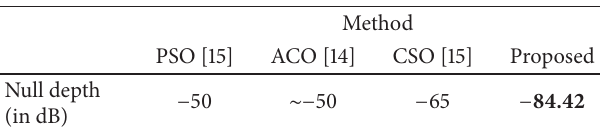
Table 5: Comparative analysis of null depth (in dB) obtained by various optimization algorithms for Example 2 .